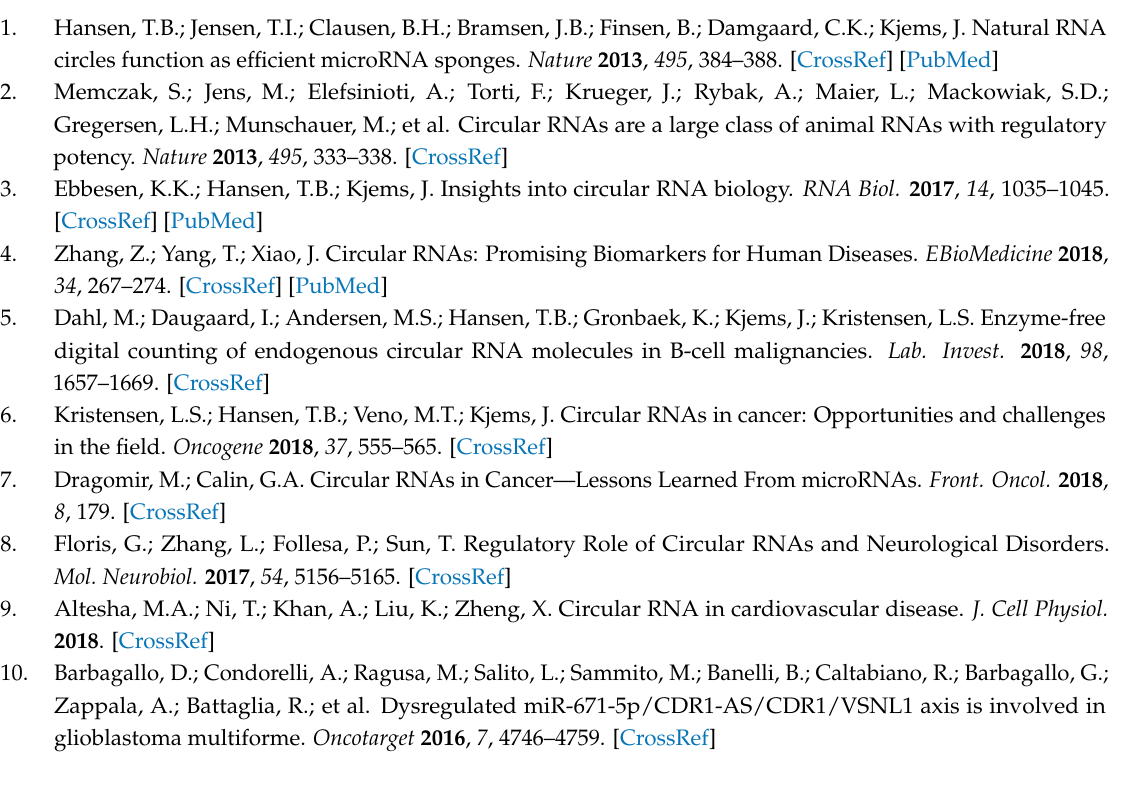
Table S1, List of SRSF1’s splicing targets retrieved by literature. Table S2, Sequences of primers used in the study. Figure S1, SRSF1 and VEGFA mRNA expression in different types of glioma (REMBRANDT database). Figure S2, SRSF1 and VEGFA mRNA expression in GBM subtypes (TCGA database). Figure S3, Box-and-whisker plots, representing the Iso8a/Iso8b ratio in GBM and UC. Figure S4, Bar graph showing Iso8A vs Iso8B ratio in three different GBM cell lines. Figure S5, CircSMARCA5 but not linear SMARCA5 is overexpressed in U87-MG transfected with pcDNA3-circSMARCA5 vector with respect to NC (U87-MG transfected with the empty vector). Figure S6, Kaplan-Meier overall survival curves of mesenchymal GBM patients, based on the expression of SRSF1. Figure S7, Diagram of primers used to amplify Iso8a and Iso8b VEGFA specific isoforms by qRT